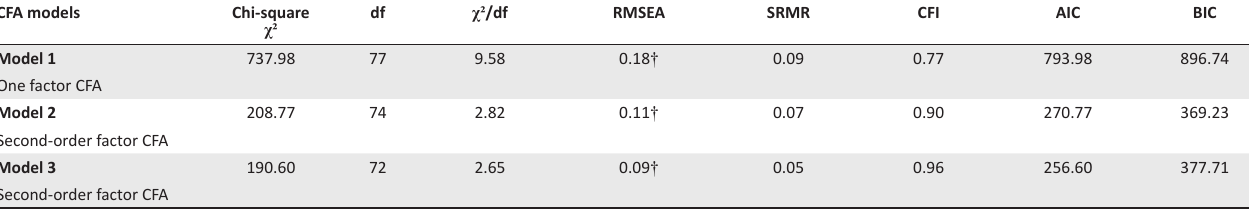
TABLE 4: Confirmatory Factor Analysis fit statistics for the Career Well-being Scale. CFA models